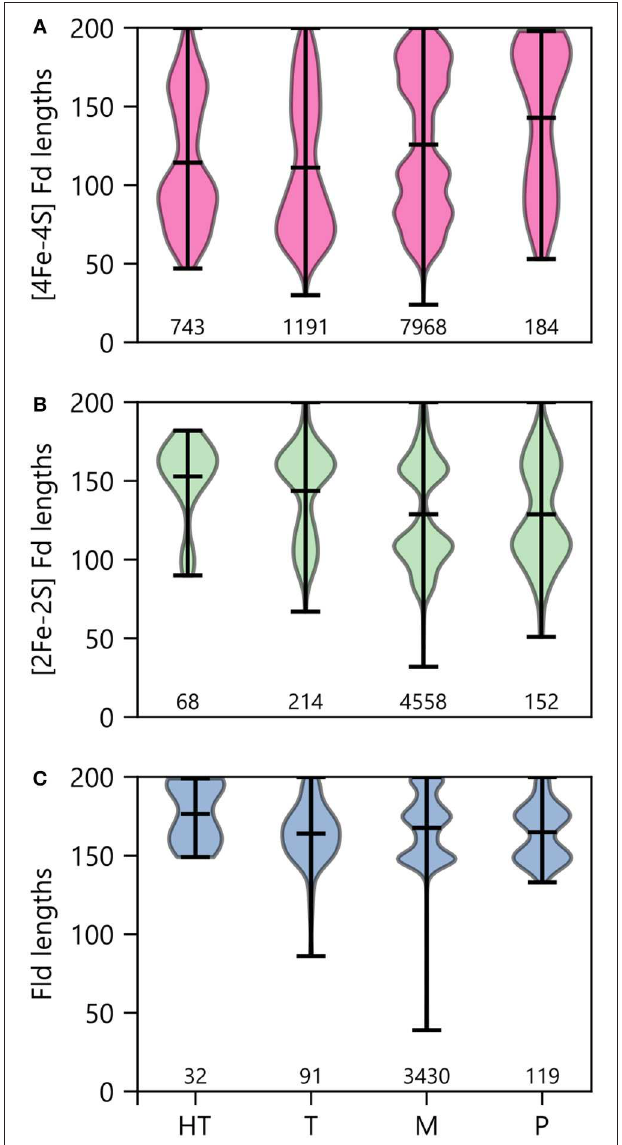
FIGURE 11 | PEC length distributions in organisms having different growth temperatures. The lengths of (A) [4Fe-4S] Fds, (B) [2Fe-2S] Fds, and (C) Flds found in organisms having different optimal growth temperatures is shown using violin plots. Optimal growth temperatures are abbreviated as hyperthermophile (H), thermophile (T), mesophile (M), and psychrophile (P). The extrema are noted with horizontal bars at the edges, and the average is noted with an internal horizontal bar. The number of individual genes in each category is listed below the plots.